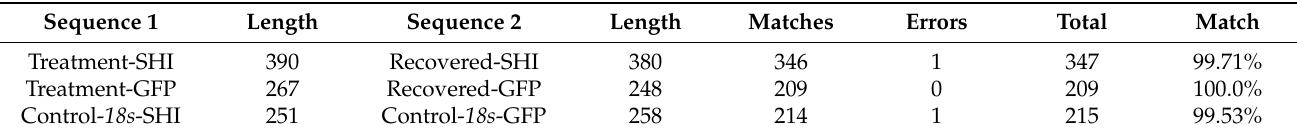
Table 1. The sequence alignment data for the treatment and recovered product pairs.